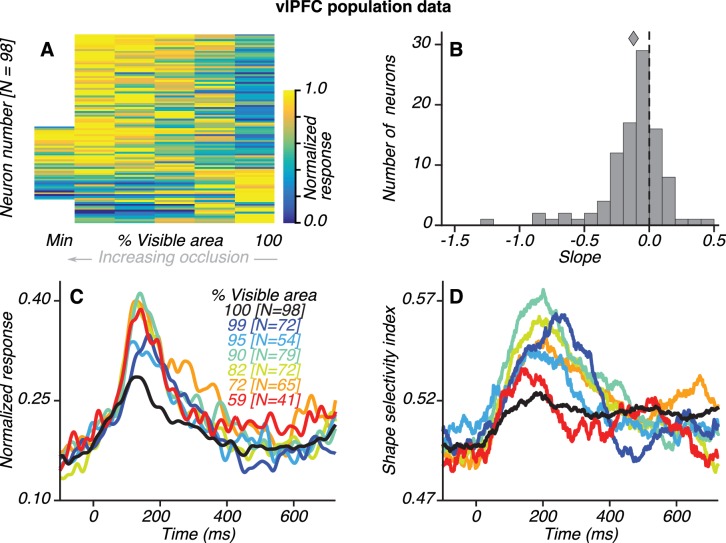
Population results for vlPFC neurons.(A) Normalized average responses (80–230 ms) to preferred shapes across occlusion level (columns). Along the abscissa, % visible area is rank ordered; so each column could represent a different occlusion level for each neuron. From left to right, occlusion level decreases and % visible area increases, with 100% representing the unoccluded case. Neurons were tested with five or six occlusion levels (62/98 and 36/98 neurons, respectively), including the unoccluded case. Responses were normalized by the maximum response for each neuron, separately. For most neurons, responses were weak (blue) for unoccluded stimuli and stronger (yellow) for higher occlusion levels. Responses to the unoccluded stimuli were strongest for only 17/98 neurons. (B) Distribution of linear regression slopes fit to the responses in A. Most neurons (71/98) had negative slopes, indicating stronger responses to occluded stimuli; the median slope was −0.12. (C) Normalized average responses derived from the responses of occlusion-sensitive neurons to the preferred shapes at different occlusion levels. vlPFC neurons were studied at 5–6 oc clusion levels chosen from a set of 9 possible values (100, 99, 95, 90, 82, 72, 59, 45% and 27% visible area). The occlusion levels presented to each neuron was different, and not all neurons were studied at all the occlusion levels listed. The numbers of neurons contributing to each curve are listed in brackets (see Materials and methods). Data for the highest occlusion levels tested (45% and 27% visible area) are not shown because too few neurons contributed to the population average and the curves for these occlusion levels were highly variable. Across the population, responses were weakest to unoccluded stimuli (black) and stronger for intermediate and high occlusion levels. (D) Average shape selectivity as a function of occlusion level. Shape selectivity was weak for unoccluded stimuli (black) at all time points whereas it gradually increased for occluded shapes (colors), reaching maximal values between ~100–300 ms. Also see Figure 3—figure supplement 1 and Figure 3—figure supplement 2.